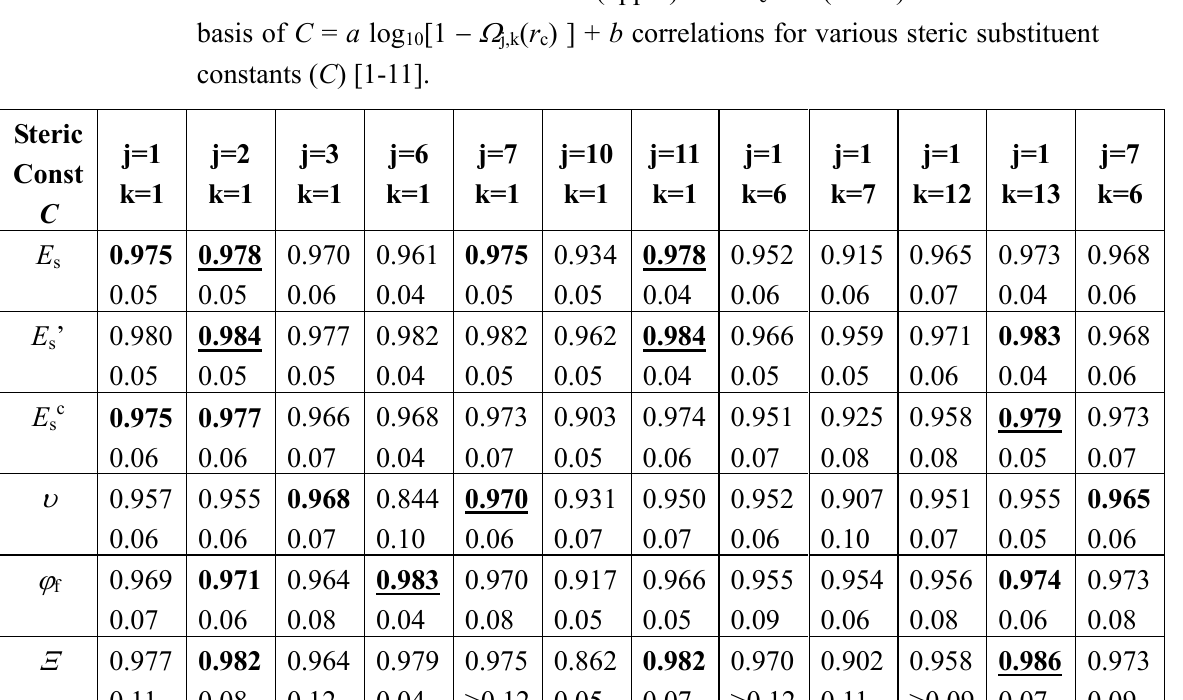
Table 3. The best correlation coefficient r (upper) and R